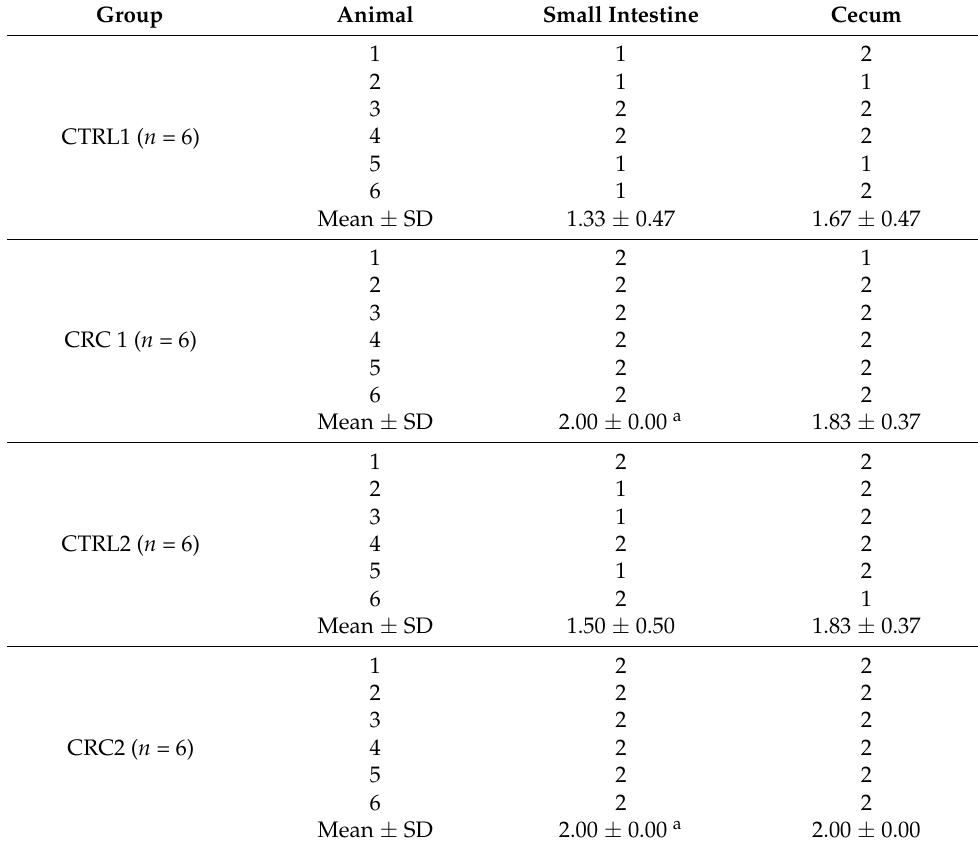
Table 4. Degree of inflammation of small intestine and cecum. Data are presented as mean ± SD. Group Animal Small Intestine Cecum